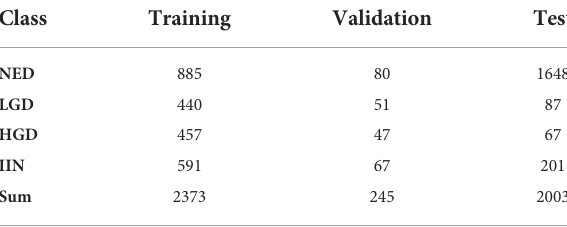
TABLE 1 Number of whole-slide images of endoscopic biopsy specimens used in the training, validation, and test